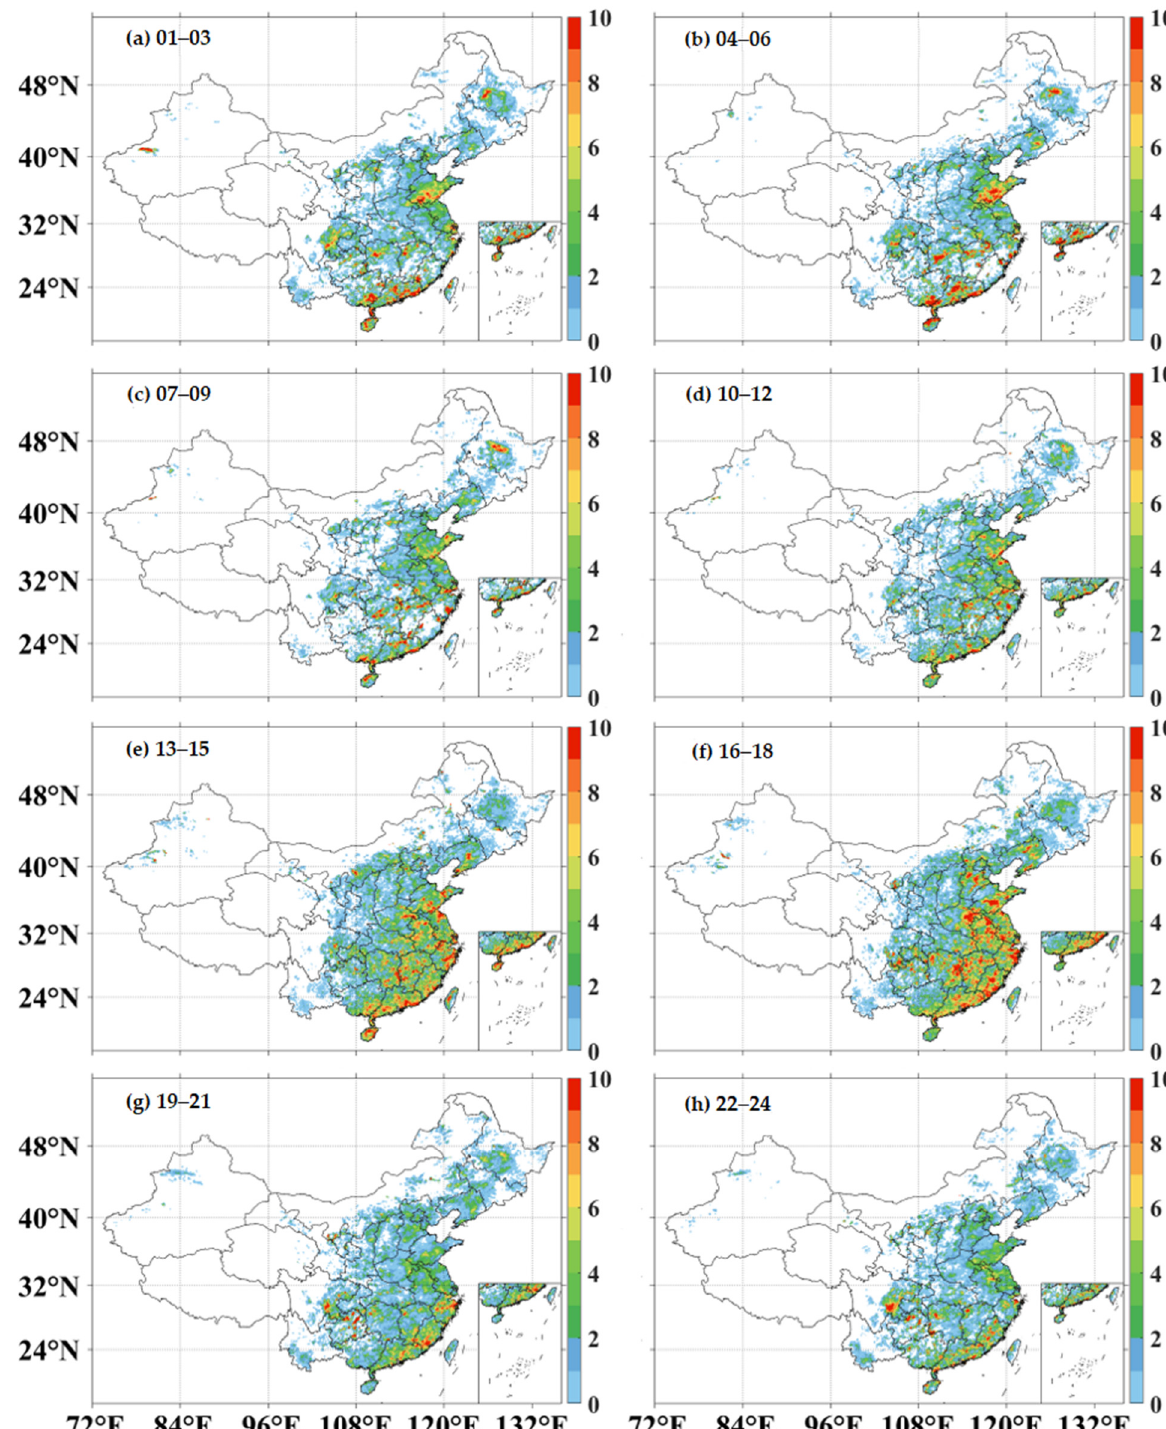
Figure 10. Diurnal variation of frequency (%) distribution of convective precipitation for period